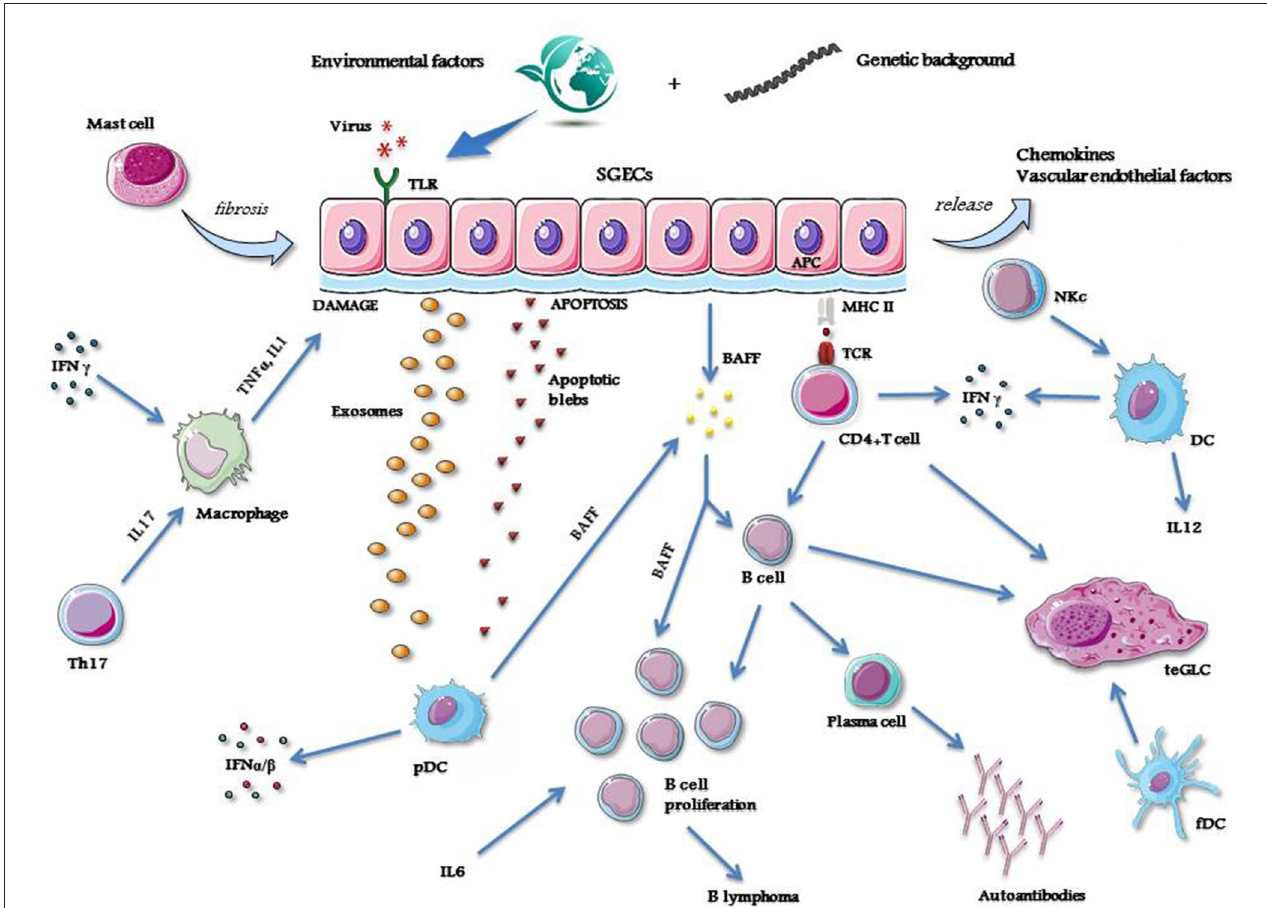
FIGURE 1 | A simplified view showing the mechanisms, cells and molecules operating as the main actors of the pathological process of pSS. APC, antigen presenting cell; BAFF, B cell activating factor; DC, dendritic cell; fDC, follicular dendritic cell; IFN, interferon; IL, interleukin; MHC, major histocompatibility complex molecule; NKc, natural killer cell; pDC, plasmacytoid dendritic cell; SGECs, salivary glands epithelial cells; TCR, T cell receptor; teGLC, tertiary ectopic germinal-like center; Th, T helper cell; TLR, Toll like receptor; TNF α , tumor necrosis factor alfa. Credit: modified from Smart Servier Medical Art,